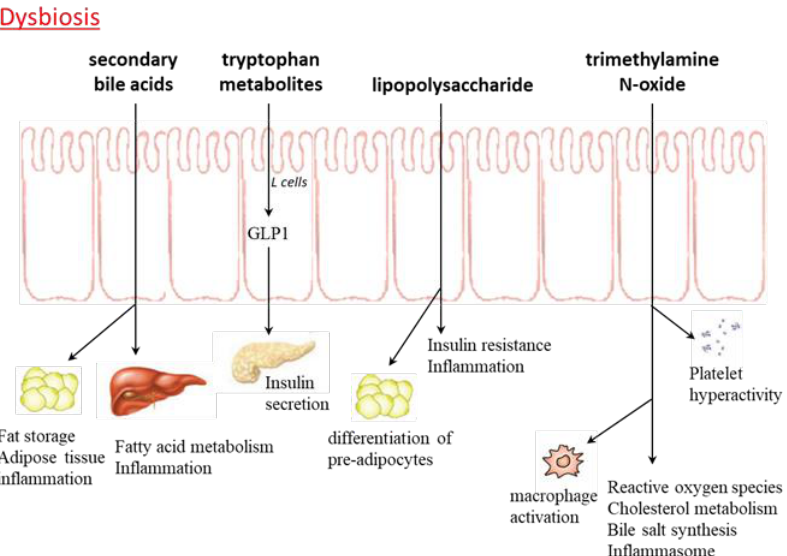
Figure 1. Gut microbiota metabolites in eubiosis and dysbiosis. GPR: G protein coupled receptor; GLP: glucagon-like peptide; PYY: peptide YY.